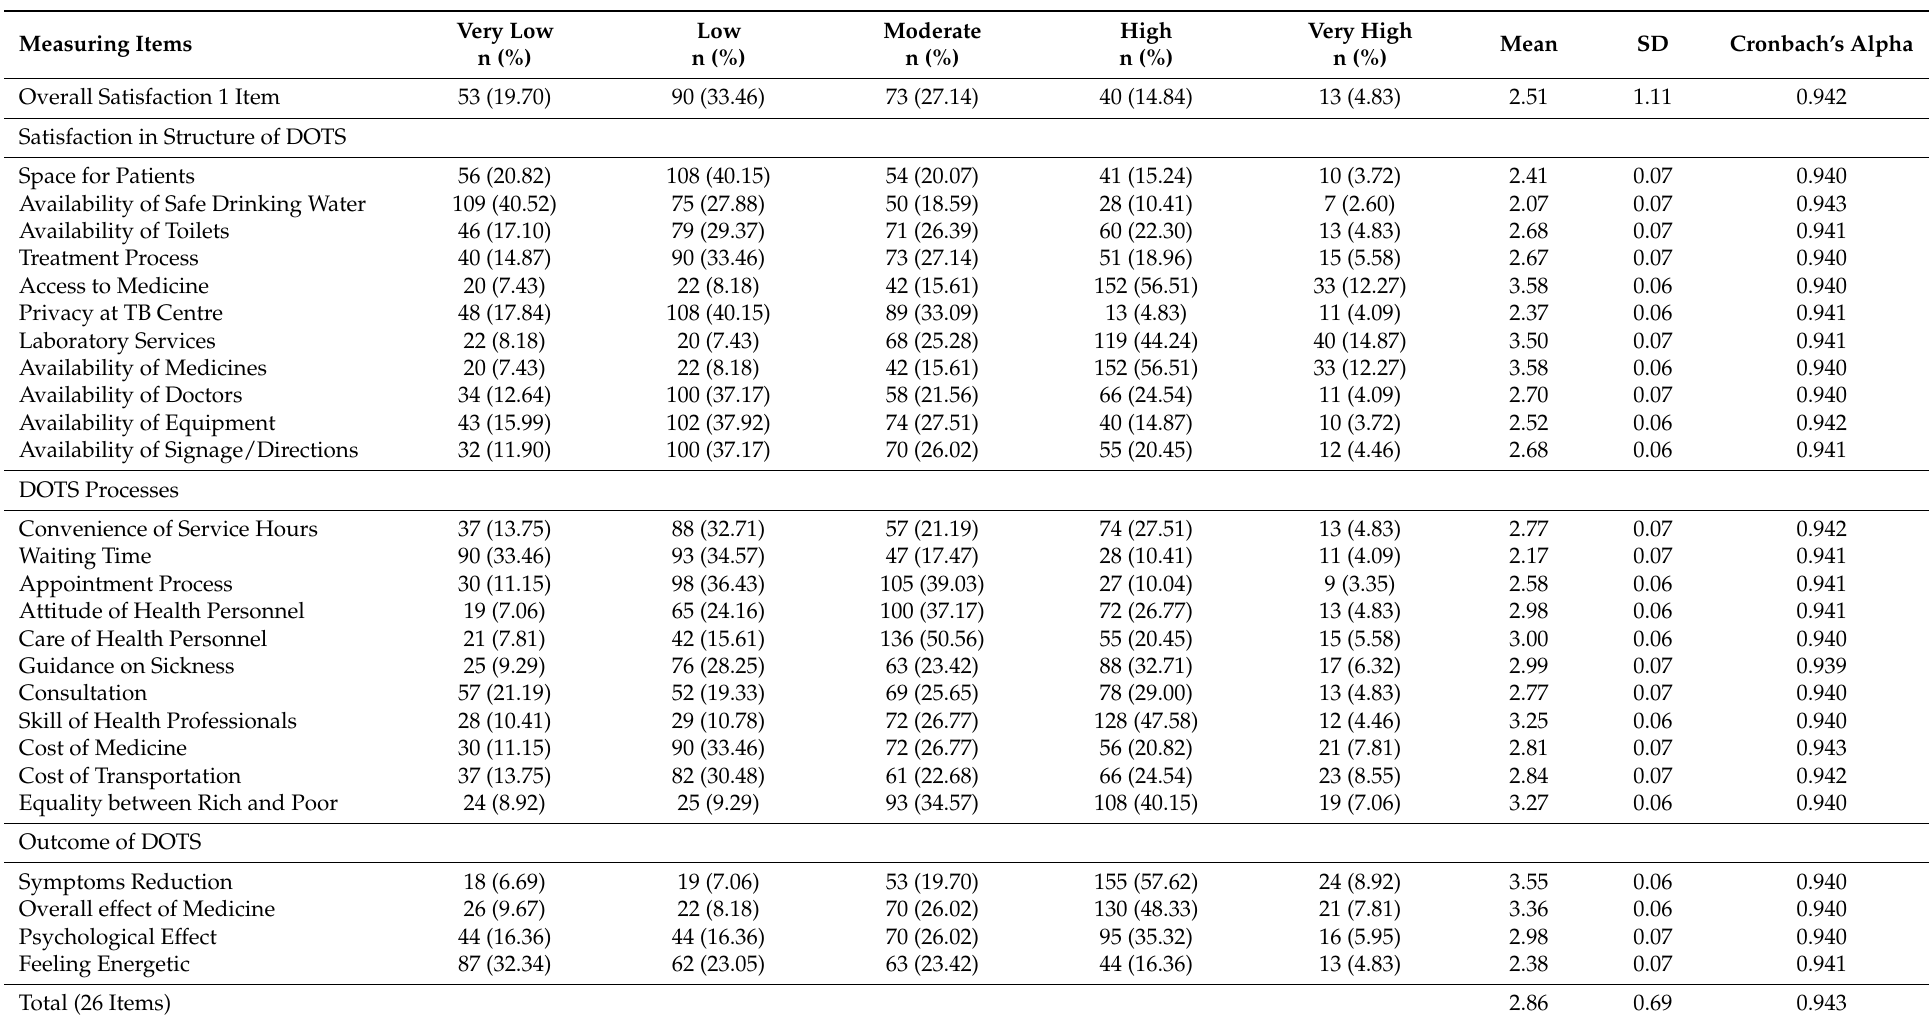
Table 1. Mean scores and reliability of satisfaction measuring